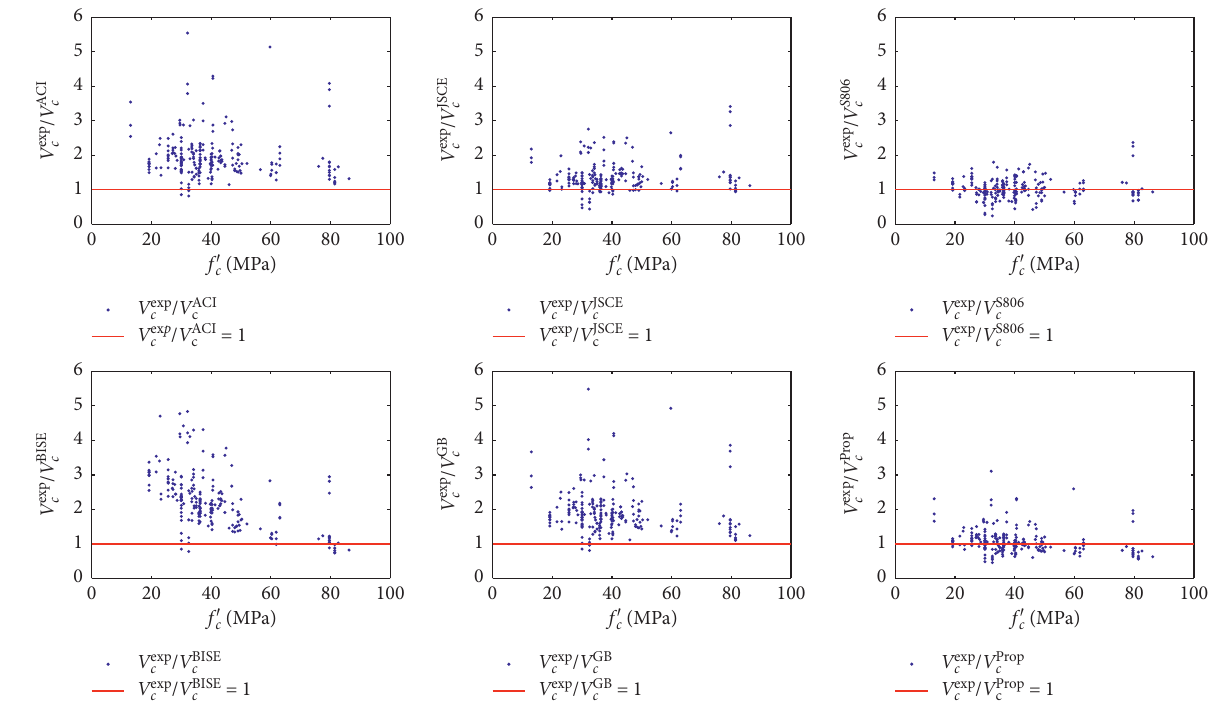
Figure 6: Comparison of ( V exp